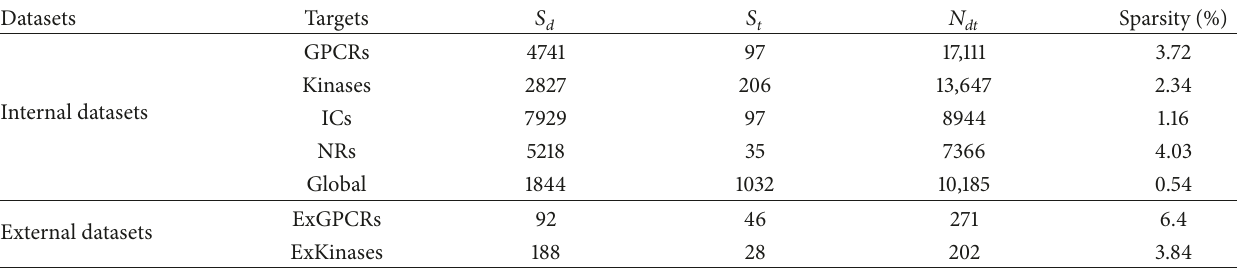
Table 1: Drugs, targets, and DTIs in each dataset.